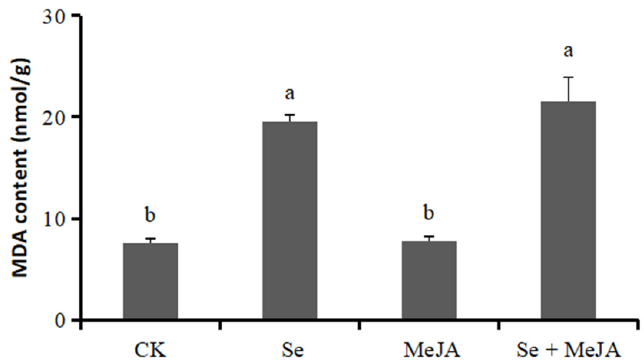
Figure 5. Effect of Se, MeJA and Se + MeJA on mycelium MDA content of Botrytis cinerea (n = 4). CK: Control group; Se: 5.0 mg/L Se; MeJA: 0.4 mM MeJA; Se + MeJA: 5.0 mg/L Se with 0.4 mM MeJA. Vertical bars indicate standard error. Columns followed by different lowercase letters are statistically different according to Duncan’s multiple range test ( p < 0.05).